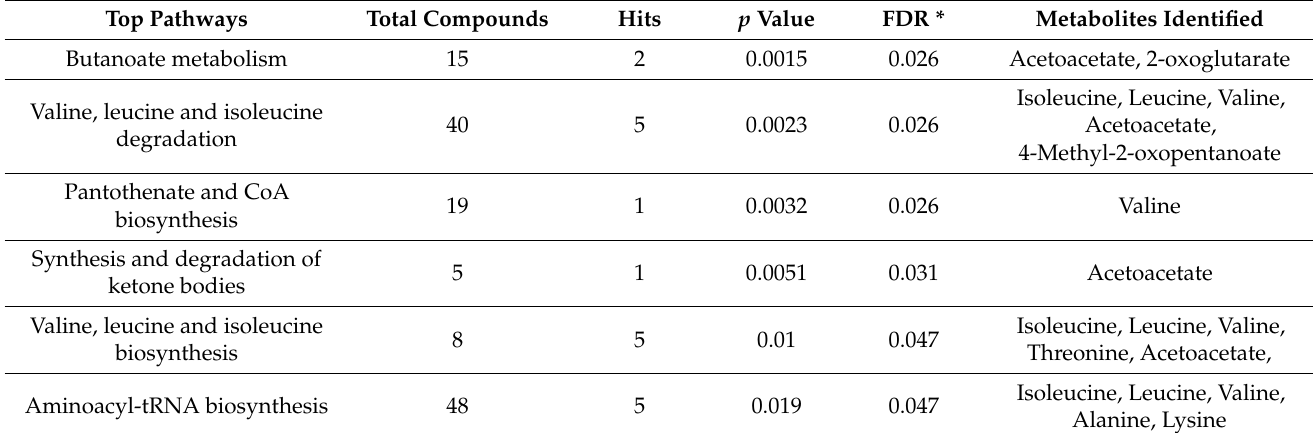
Figure 5. Metabolite set enrichment analysis of significantly altered urine metabolites according to the KEGG database. Table 2. Top pathways enriched with metabolites having significantly altered abundance in Zucker diabetic fatty rats fed with cocoa diet (ZDF-C), as identified by the pathway analysis using Metabo- Analyst.